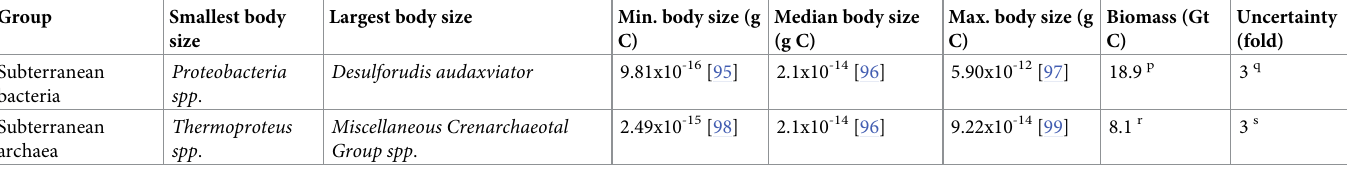
Table 4. Subterranean consumer body